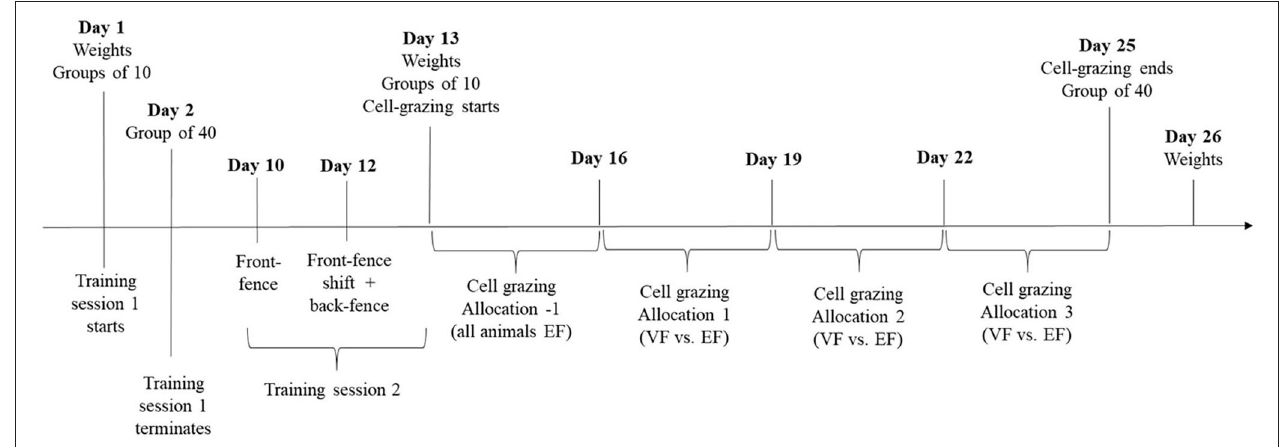
FIGURE 1 | Experimental timeline. Four groups of 10 naïve heifers underwent an initial virtual fencing training session in four adjacent paddocks. This was canceled after 5.5h when, for reasons unknown, there was movement of heifers beyond the virtual boundary. Heifers were returned to a single mob of 40 animals. A second and successful 3 day training session was conducted 8 days later. The modified training session incorporated a moving virtual front-fence and virtual back-fence. After training the 40 heifers were weighed and drafted into one of four groups of 10 animals. Groups were allocated to a virtual or electric-fence treatment before being moved to their respective paddocks and studied over four 3 day grazing allocations. All animals were contained with electric fencing for the first allocation which served as an adjustment period (allocation − 1). Groups were managed with electric (EF) or virtual-fences (VF) for subsequent 3 day grazing allocations. Heifers were returned to a group of 40 animals and weighed at the end of the 12 days of